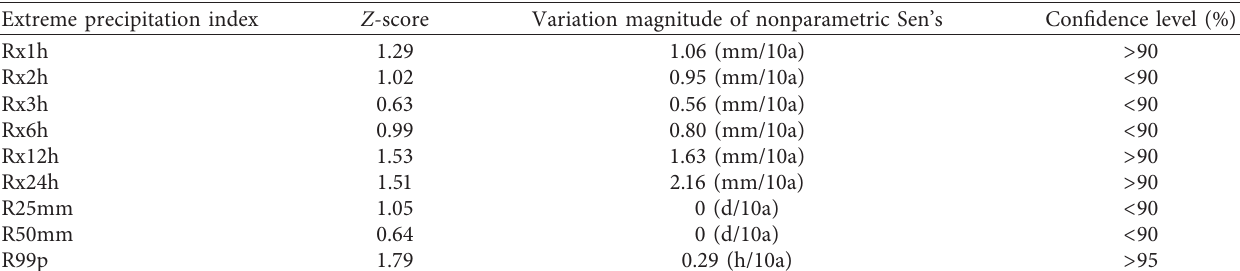
Table 2: MK tests and slopes of indices of extreme precipitation in the central urban area of the study area. Extreme precipitation index Z -score Variation magnitude of nonparametric Sen’s Confidence level (%) Rx1h 1.29 1.06